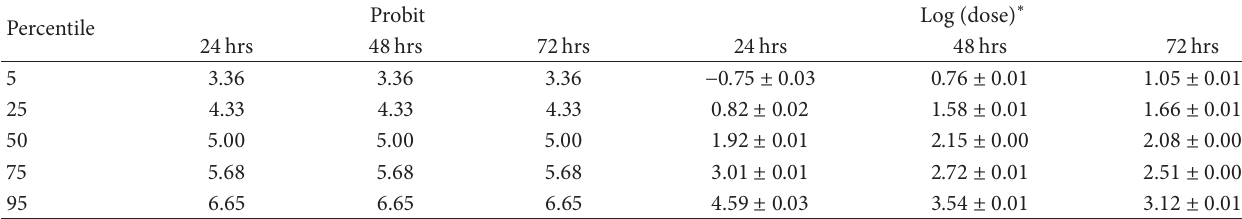
Table 3: Effective concentration and time interval on the percentage cell death.